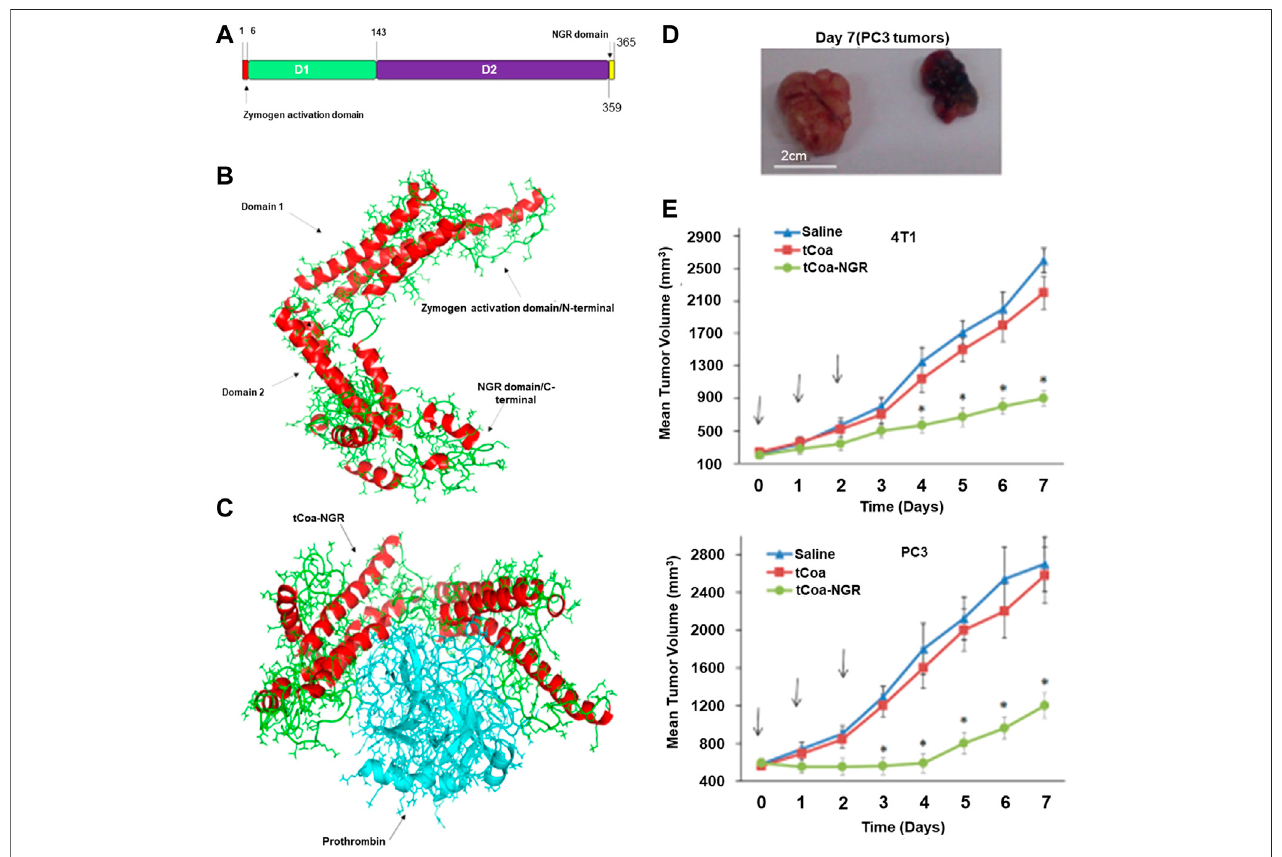
FIGURE 2 | Molecular dynamic studies of tCoa-NGR proteins and therapeutic potential of tCoa-NGR proteins in vivo (A) Protein structure of tCoa-NGR (B) 3D structureoftCoa-NGR (C) Molecular dynamic simulationoftCoa-NGR-prothrombin complex (D) .Illustrative photos ofmice bearing prostate cancerxenografts (PC3) at the end of treatment treated with tCoa-NGR (right) or tCoa (left) (E) 4T1 and PC3 tumor-bearing mice were treated by the indicated formulations. Reprinted with permission from (Seidi et al.,